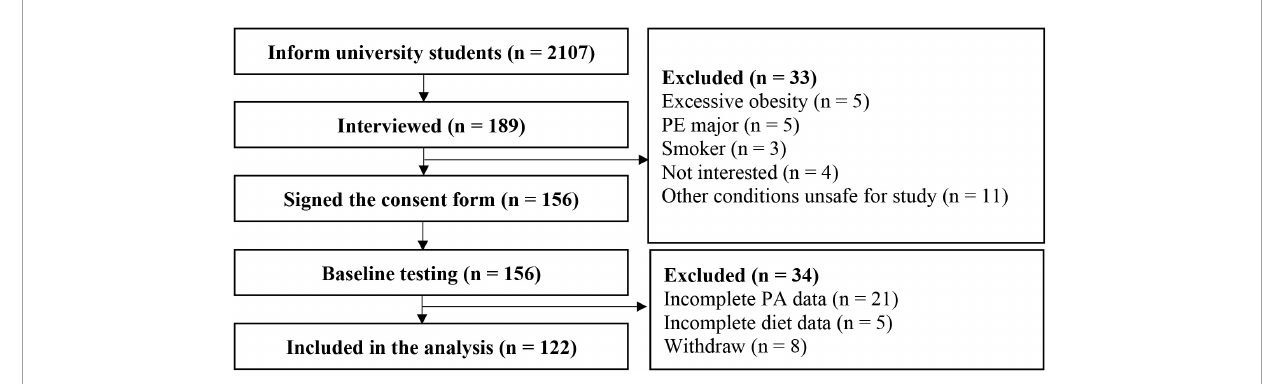
FIGURE1 The process of sample. PA, physical activity; PE, physical education.